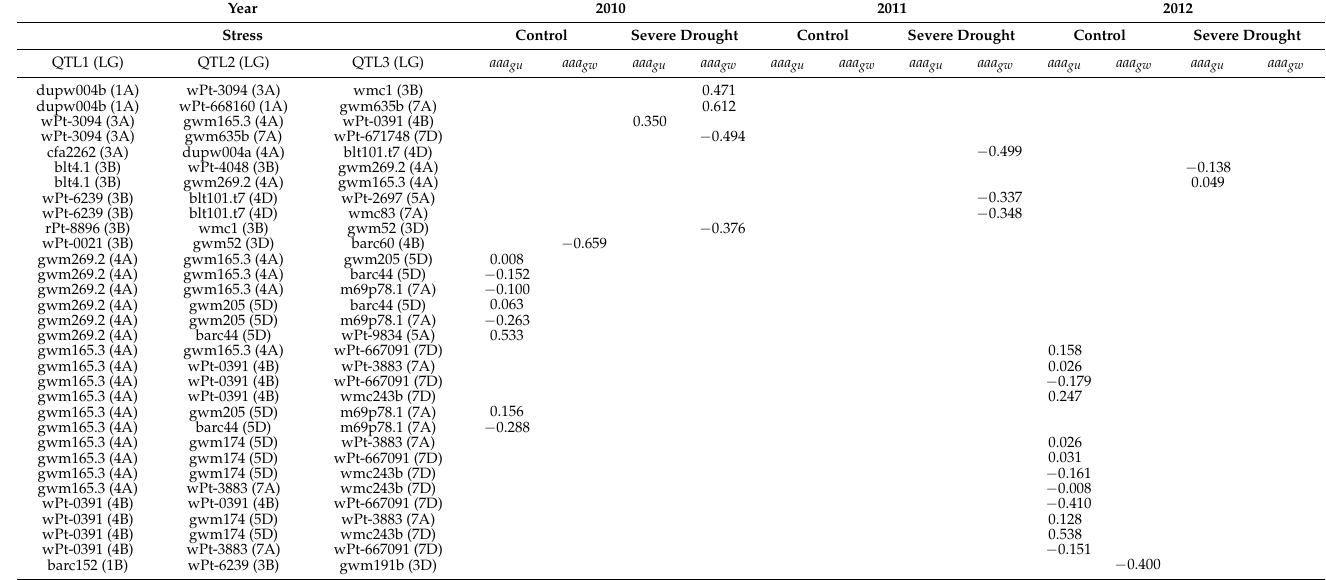
Table 3. Genotypic estimates of the additive × additive × additive interaction effects for the particular QTL × QTL × QTL threes based on unweighted ( aaa gu ) and weighted ( aaa gw ) multiple linear